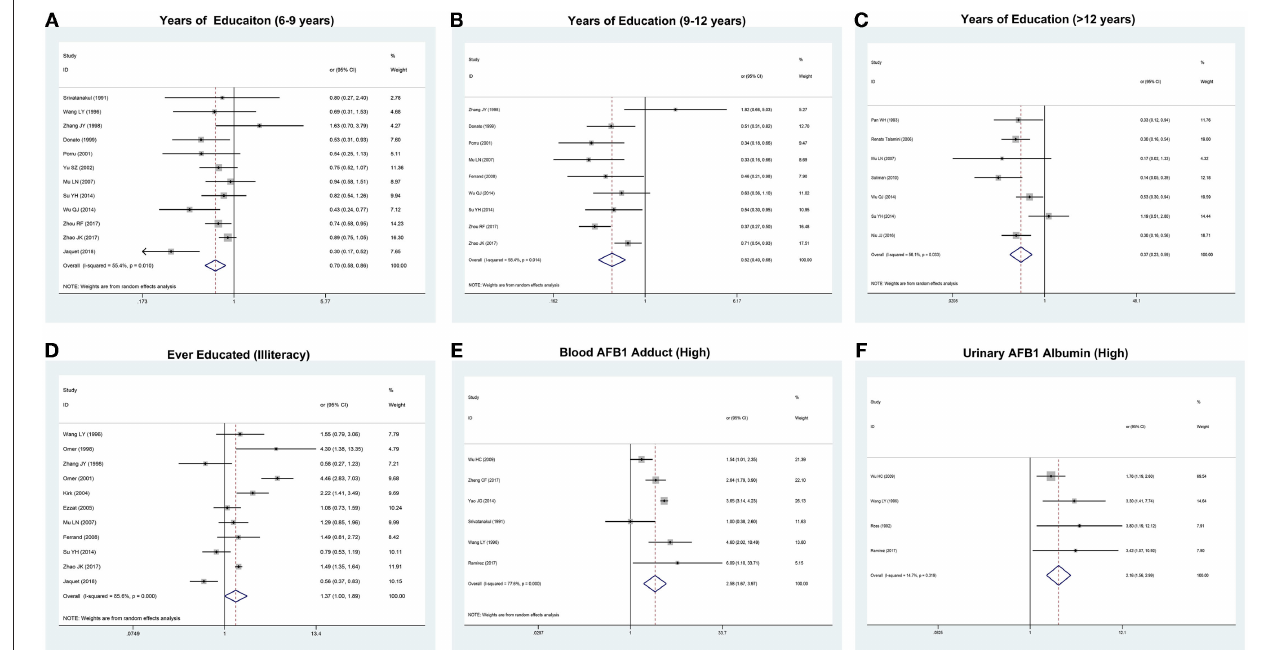
FIGURE 2 | The forest plots of the association between the risk factors and hepatocellular carcinoma (HCC). (A) Association between years of education (6–9 years) and HCC. (B) Association between years of education (9–12 years) and HCC. (C) Association between years of education ( > 12 years) and HCC. (D) Association between ever educated (illiteracy) and HCC. (E) Association between blood aflatoxin B1 (AFB1) adduct (high) and HCC. (F) Association between urinary AFB1 albumin (high) and HCC.